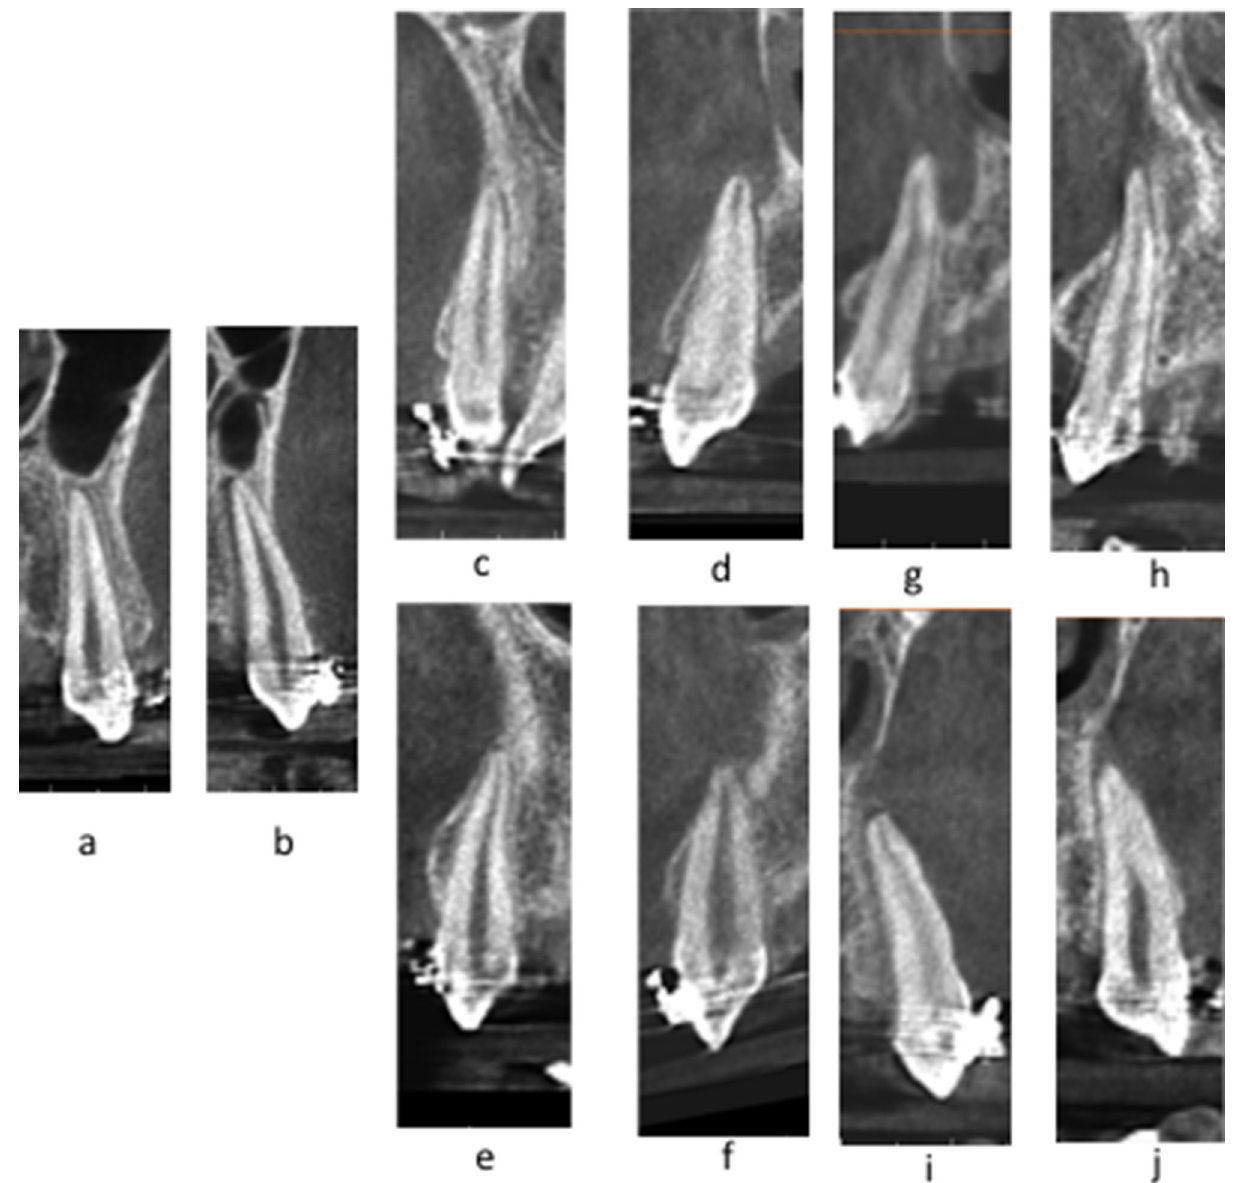
Figure 6. (a,b) Canines of the same patients in Grade A in the pre-retraction position (a) changed to grade C in the post-retraction position (b), (c–f) canines of the same patients in Grade B in the pre-retraction position (c,e) changed to grade C in the post-retraction position (d,f) , (g–j) canines of the same patients in Grade C in the pre-retraction position (g,i) remained as grade C in the post-retraction position (h,j)